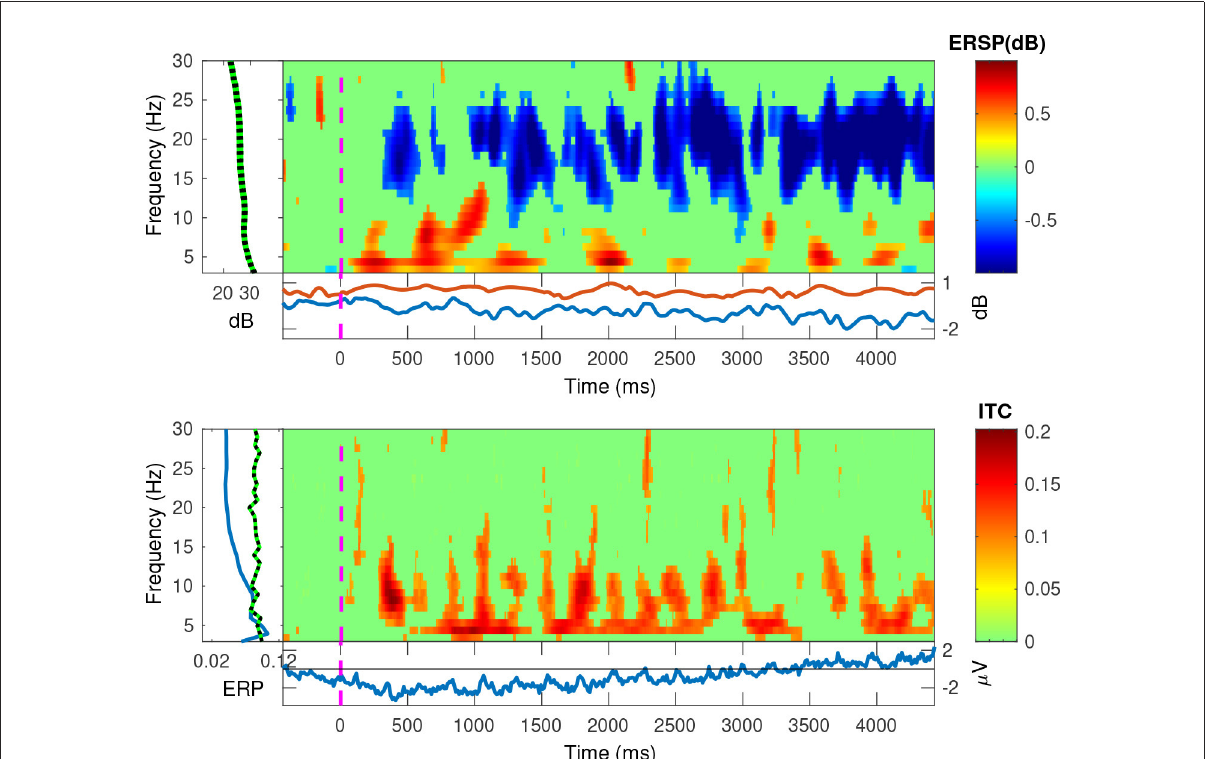
FIGURE11 The EEGLAB output for our pooled data, for the correlated condition: The ESRP plots show relative spectral power density changes as a function of time, and the ITC plots show the coherency values as a function of time. The green area is a mask to hide statistically insignificant data. The band at the low frequencies in both plots show a strong neural response at the second and fourth harmonics of the stimulus. The ESRP plot also shows a marked decrease in the beta (13–30 Hz)